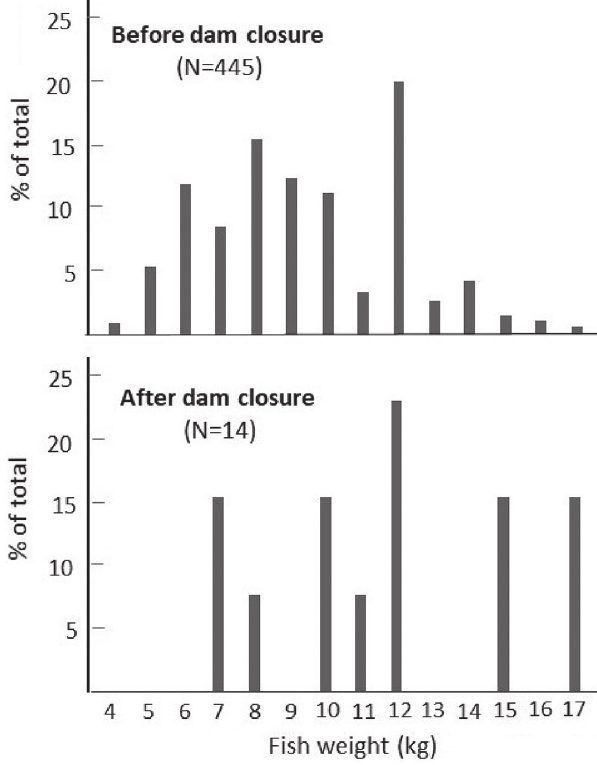
Fig. 4. Fish weight frequency distribution of Brachyplatystoma rousseauxii before and after dam